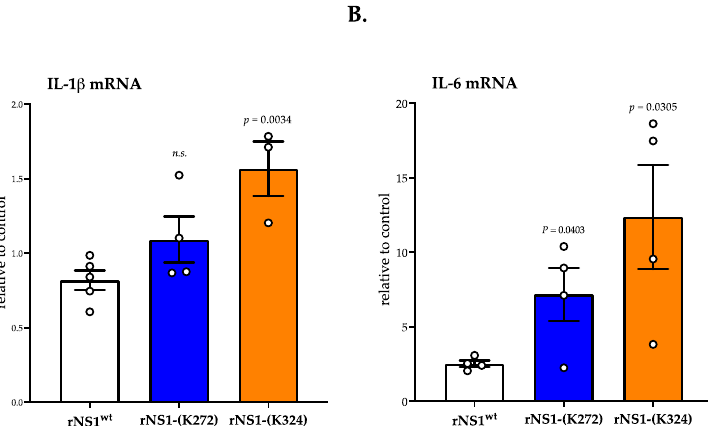
Figure 5. Pro-inflammatory cytokine activation in Huh7 cells expressing the rNS1-(K324) mutant. Huh7 cells were transfected for 24 h with plasmids expressing rNS1 wt or the rNS1-(K272) and rNS1- (K324) mutants. The IL-1 β ( A ) and IL-6 ( B ) transcripts were quantified by RT-qPCR. Results are expressed as the fold induction of transcripts in samples relative to those in mock-transfected cells. The results are the mean (± SEM) at least three replicates (open circles). p -values were determined on the comparison of rNS1 mutants versus rNS1 wt .